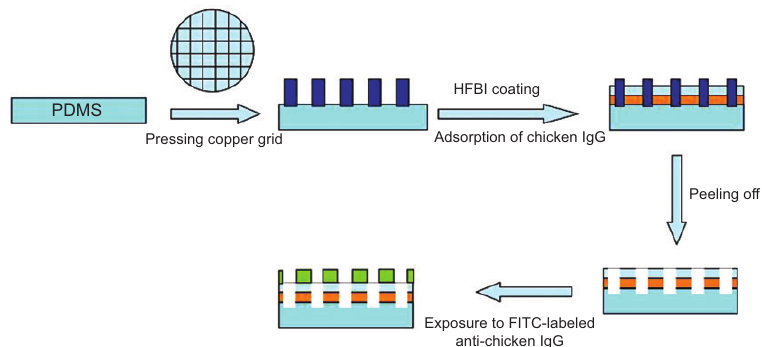
Figure 1 HFBI coating and immunoassay on the PDMS surface (Qin et al. 2007